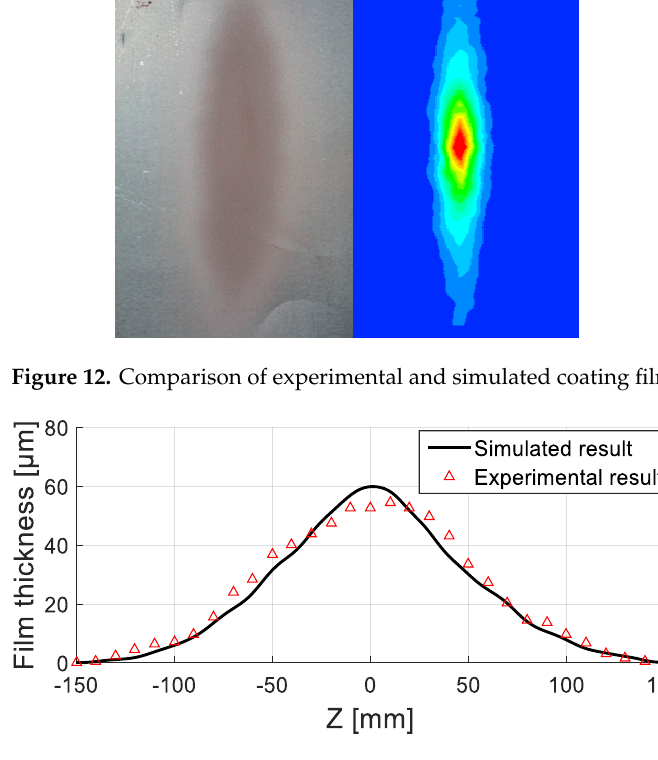
Figure 13. Plane vertical spraying: comparison of experimental and simulated coating film thickness distribution in the plane X = 0.